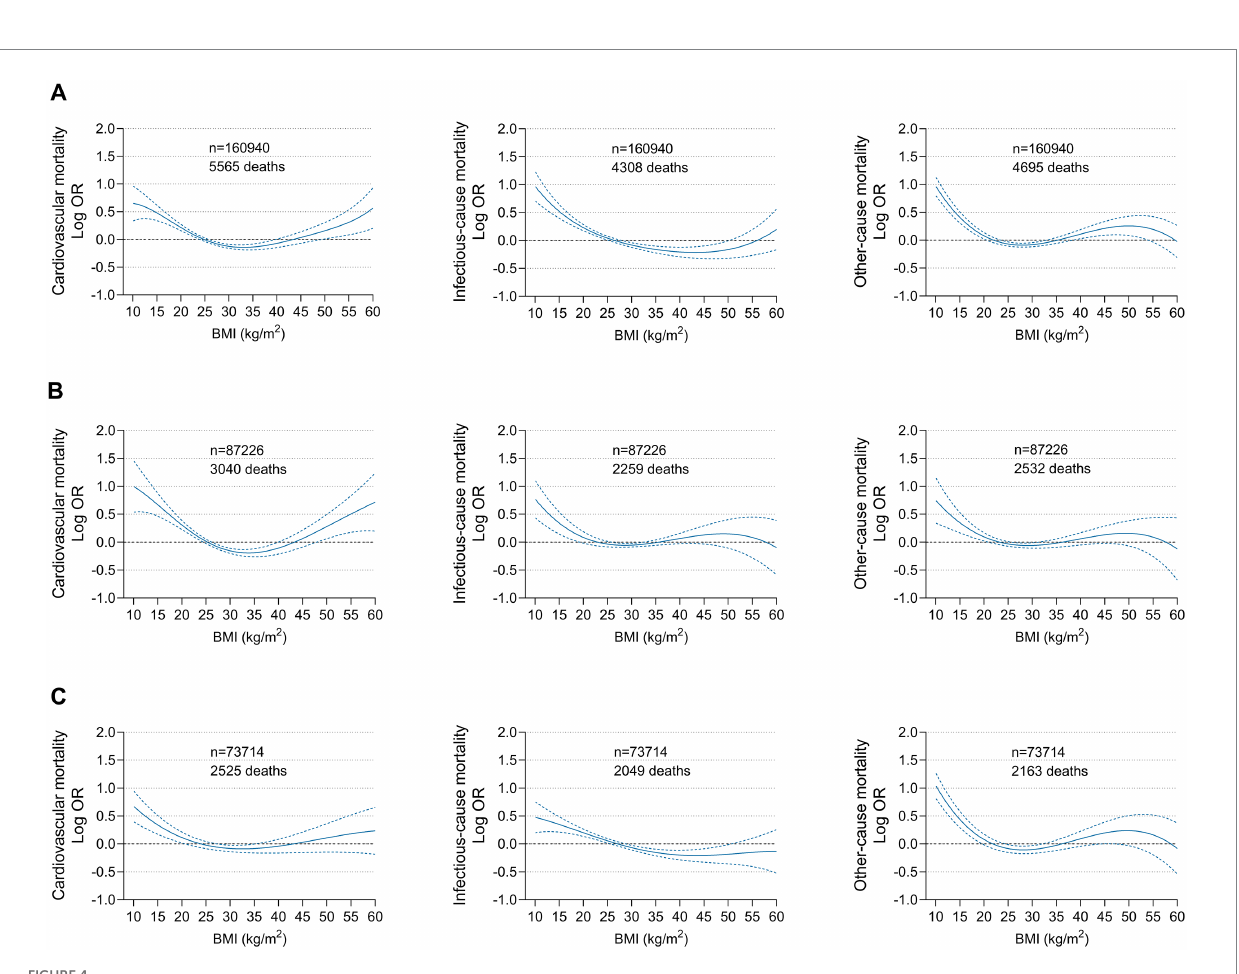
FIGURE 4 Multivariable adjusted odds ratios for cause-specific mortality according to BMI on a continuous scale among (A) Overall population, (B) Men and (C) Women. Odds ratios (solid line) and 95% confidence intervals (dashed lines) were from cubic spline curves based on the generalized additive